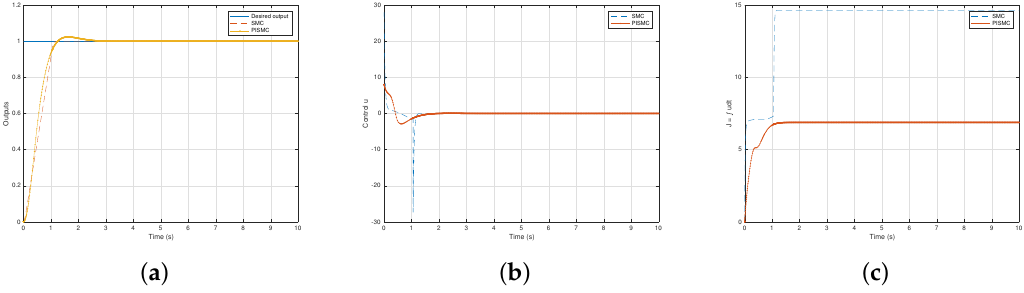
Figure 6. Comparison of parameter effectiveness. ( a ) Outputs ˜ x ; ( b ) control input ˜ u ; ( c ) cost of controls J